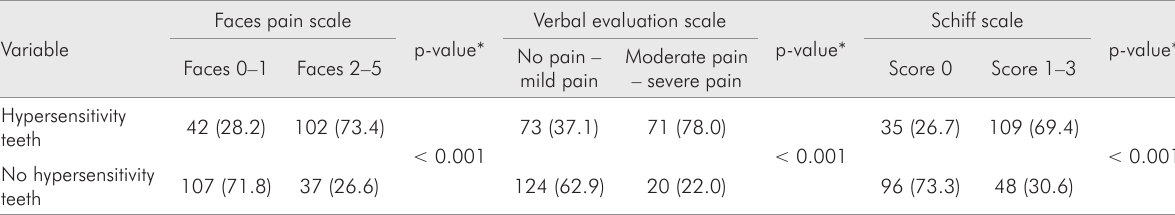
Table 3. Association between hypersensitive teeth and the faces pain scale, verbal evaluation scale, and Schiff scale. Variable